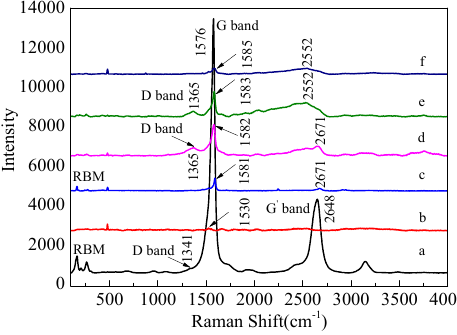
Figure 6. Raman spectra of ( a ) SWCNTs; ( b ) PAN nanofiber; and corresponding composite nanofibers with the different SWCNT concentrations of ( c ) 0.5 wt %; ( d ) 1 wt %; ( e ) 1.5 wt %; ( f ) 2 wt %.